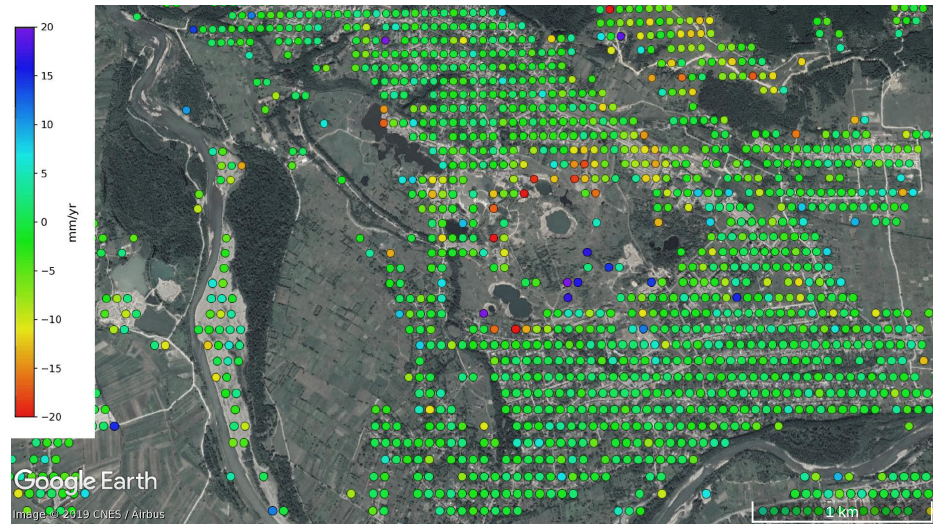
Figure 12. East–west (positive in east direction) deformation rate of the area of interest computed from ascending and descending deforma- tion rates. Contains modified Copernicus Sentinel data (2014–2019), background © Google